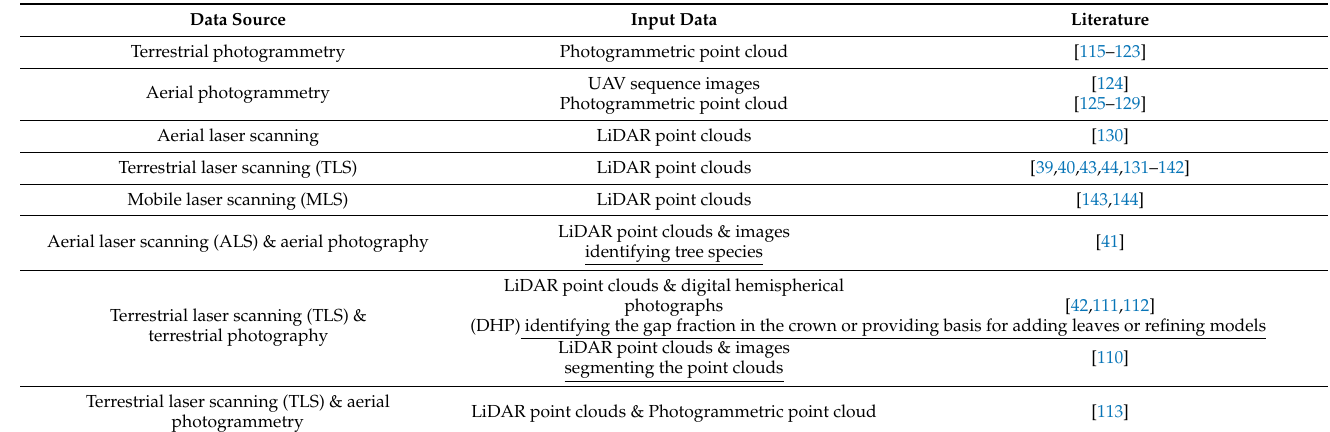
Table 6. Input data sources for tree